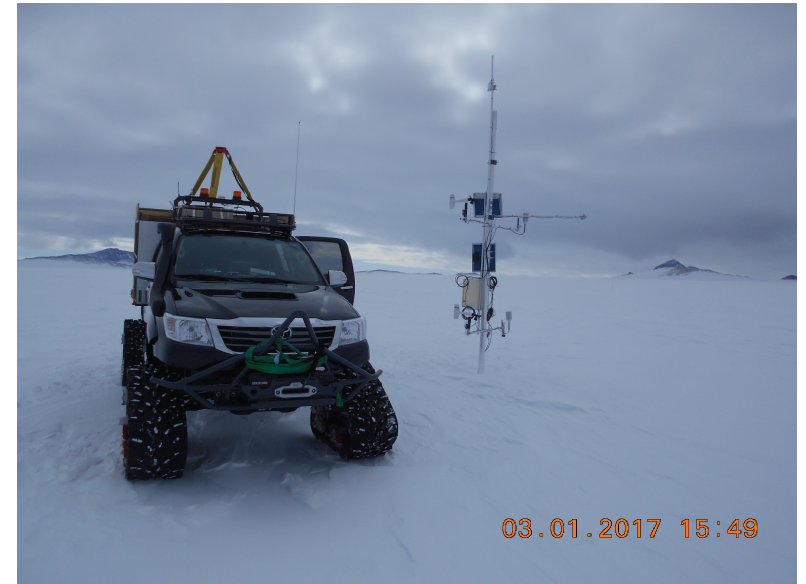
Figure 1. Mobile, carrying out the channel characterization experiments at one of the fixed wireless sensor nodes, monitoring meteorological conditions in the